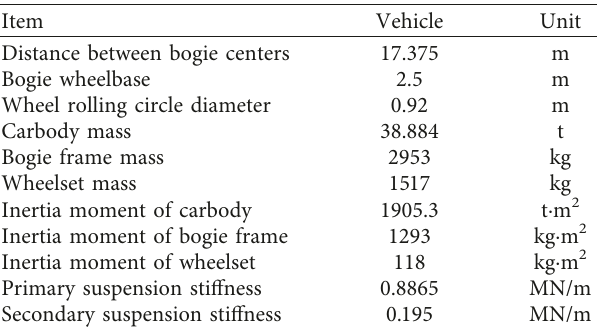
Figure 3: Procedure of investigating TTI with ANSYS adopting APDL language. Table 2: Parameters of the adopted